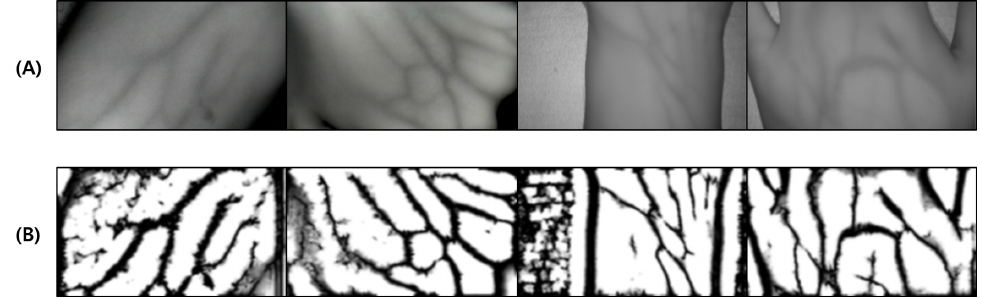
Figure 13. Images obtained by applying the vein image processing algorithm: ( A ) is the original image taken with an NIR camera, and ( B ) is the resultant image obtained through the proposed algorithm.